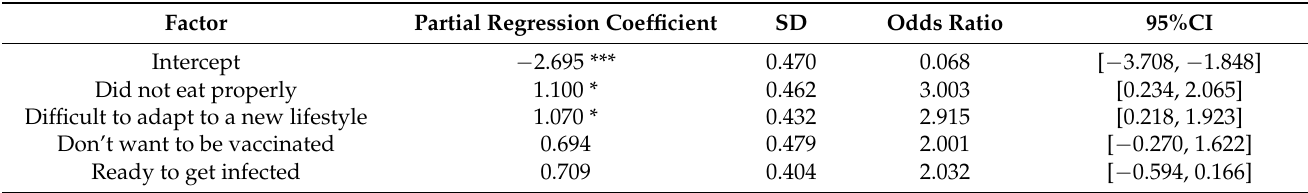
Table 6. Binormal regression of the responses to the question “Has the pandemic changed your self-assessment of health status?” (Niigata boys).